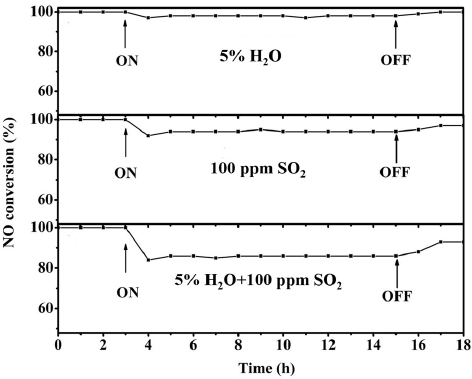
Figure 10. H 2 O resistance, SO 2 tolerance, and H 2 O and SO 2 synergetic effect study of the MnCo 2 O 4 catalyst at 200 °C (Reaction conditions: [NO] = [NH 3 ] = 500 ppm, [O 2 ] = [H 2 O] = 5 vol%, [SO 2 ] = 100 ppm, N 2 balance, and GHSV = 50,000 h − 1 ). (Reproduced with permission from Reference [30], Copyright 2015, Elsevier.).